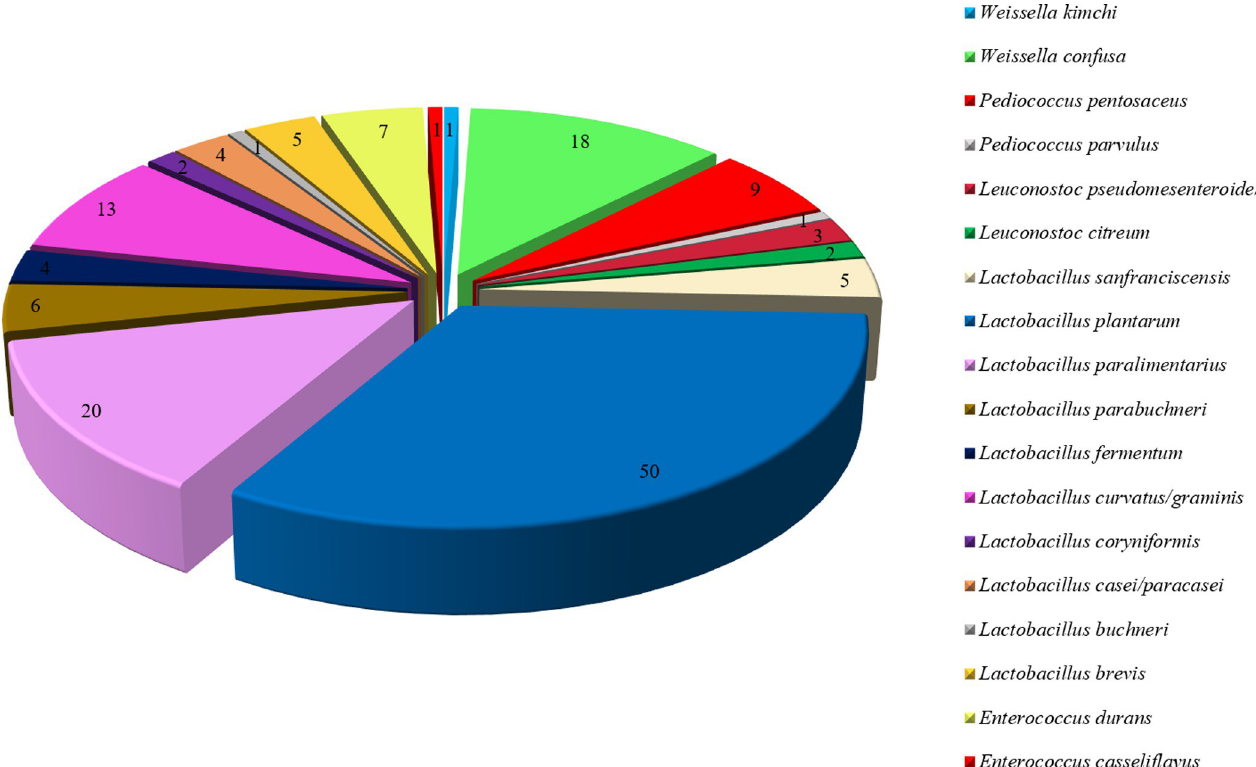
Fig 1. Species distribution of the 152 lactic acid bacteria (LAB) analyzed in this study (for each sector, the number of isolates is reported).